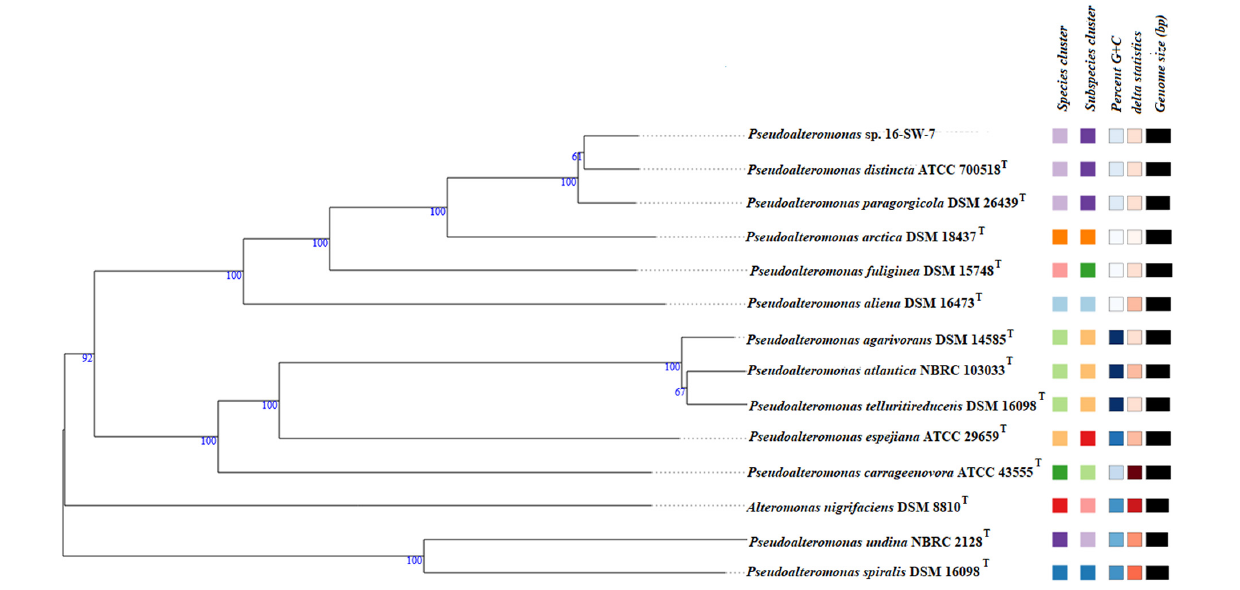
FIGURE 1 | Tree inferred with FastME 2.1.6.1 from GBDP distances calculated from genome sequences by the TYGS server (Lefort et al., 2015). The branch lengths are scaled in terms of GBDP distance formula d5. The numbers above the branches are GBDP pseudo-bootstrap support values > 60% from 100 replications, with an average branch support of 92.7%. The tree was rooted at the midpoint (Farris, 1972). The square labels colored by the same color indicate the genomes with the same species (light lilac) and subspecies (dark lilac) gene clusters, G+C content (white), and delta statistics: Pseudoalteromonas _GCF_005877035.1 (the strain 16-SW-7), P. distincta ATCC 700518 T , and P. paragorgicola DSM 26439 T form one phylogenomic clade separated from other species of the